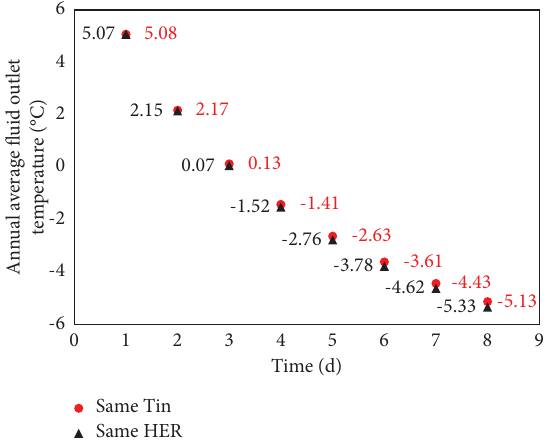
Figure 13: Annual average carrying fuid outlet temperature during the 8-year operation of the